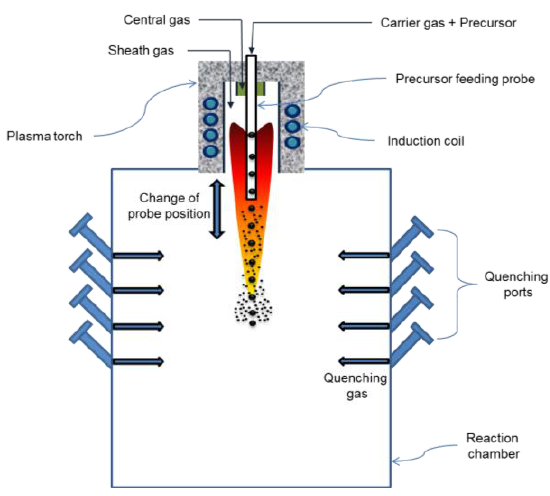
Figure 1. Schematic illustration of precursor feeding probe and quenching ports in the RF thermal plasma